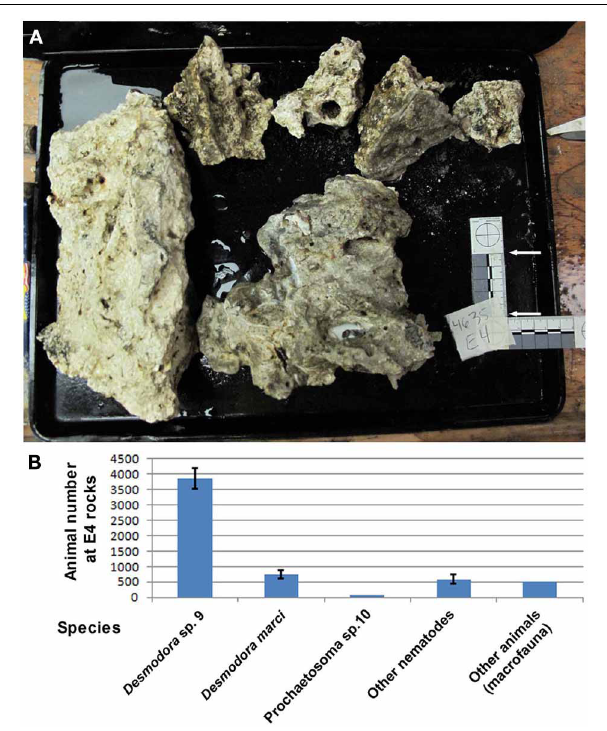
FIGURE 2 | Desmodora nematodes dominate Hydrate Ridge carbonate rock ecosystems. (A) Hydrate Ridge South E4 carbonate rocks that were sampled and processed on the ship in August 2010. The combined surface area of these rocks is 0.1615m 2 . (B) Animal densities at Hydrate Ridge south E4 rock calculated as individuals per combined E4 rock. Nematode numbers represent the average of three samples 1/120th of the total fraction recovered from the rocks. “Other animals” are the total number of meiofauna and macrofauna (mainly Polychaeta) found in E4 rock. Desmodora and Prochaetosoma worms are 83.6% of the total meio and macrofauna animals living on E4 rock. Bars represent standard errors.